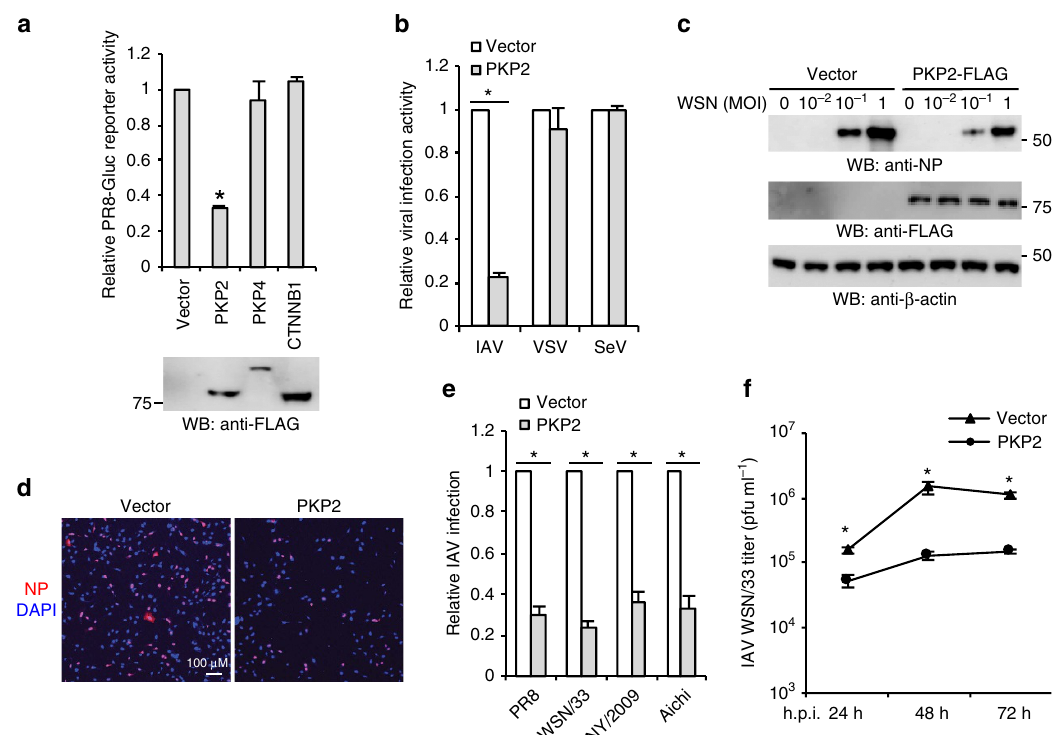
Figure 4 | PKP2 restricts IAV infection. ( a ) HEK293 cells were transfected with pCMV3-tag-8 vector, PKP2-FLAG, PKP4-FLAG or CTNNB1 ( b -catenin)- FLAG for 24h, followed by infection with 0.1 MOI of PR8-Gluc for 16h. Luciferase activity assays were performed. All experiments were biologically repeated three times. Data represent means ± s.d. of three independent experiments. The P value was calculated (two-tailed Student’s t -test) by comparison with the vector control. An asterisk indicates P o 0.05. Western blot shows the protein expression levels from one experiment. ( b ) HEK293 cells transfected with PKP2-FLAG or pCMV3-tag-8 vector were infected with 0.1 MOI of IAV-Gluc, VSV-Luc and SeV-Luc for 16h. Data represent means ± s.d. of three independent experiments. The P value was calculated (two-tailed Student’s t -test) by comparison with the vector control. An asterisk indicates P o 0.05. ( c ) HEK293 cells were transfected with pCMV3-tag-8 vector or PKP2-FLAG for 24h, then infected with WSN/33 IAV for 16h. Cell lysates were blotted using the indicated antibodies. ( d ) HEK293 cells were transfected with pCMV3-tag-8 vector or PKP2-FLAG for 24h, then infected with WSN/33 IAV for 16h. Fixed cells were stained with an anti-NP antibody. The percentage of stained cells is summarized in e . ( e ) HEK293 cells were transfected with the pCMV3-tag-8 vector or PKP2-FLAG for 24h, then infected with 1 MOI of PR8, WSN/33, NY/2009 or Aichi IAV for 16h. Fixed cells were stained with anti-NP antibody (PR8 and WSN/33), anti-HA (NY/2009) or anti-Aichi antibodies. The relative infection was determined by the ratio